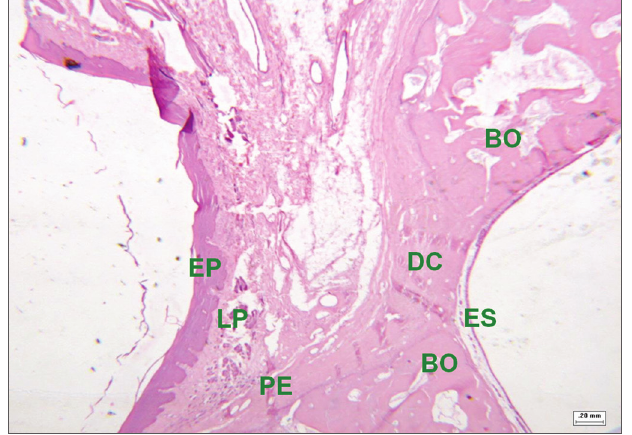
Figure 7. Histological section of an experimental surgical defect not completely filled with bone (hematoxylin-eosin stained) - surgical de- fect (DC) containing fibrous connective tissue; squamous epithelium (EP); lamina propria (LP); bone ridges (BO); periosteum (PE); sinus epithelium (ES).